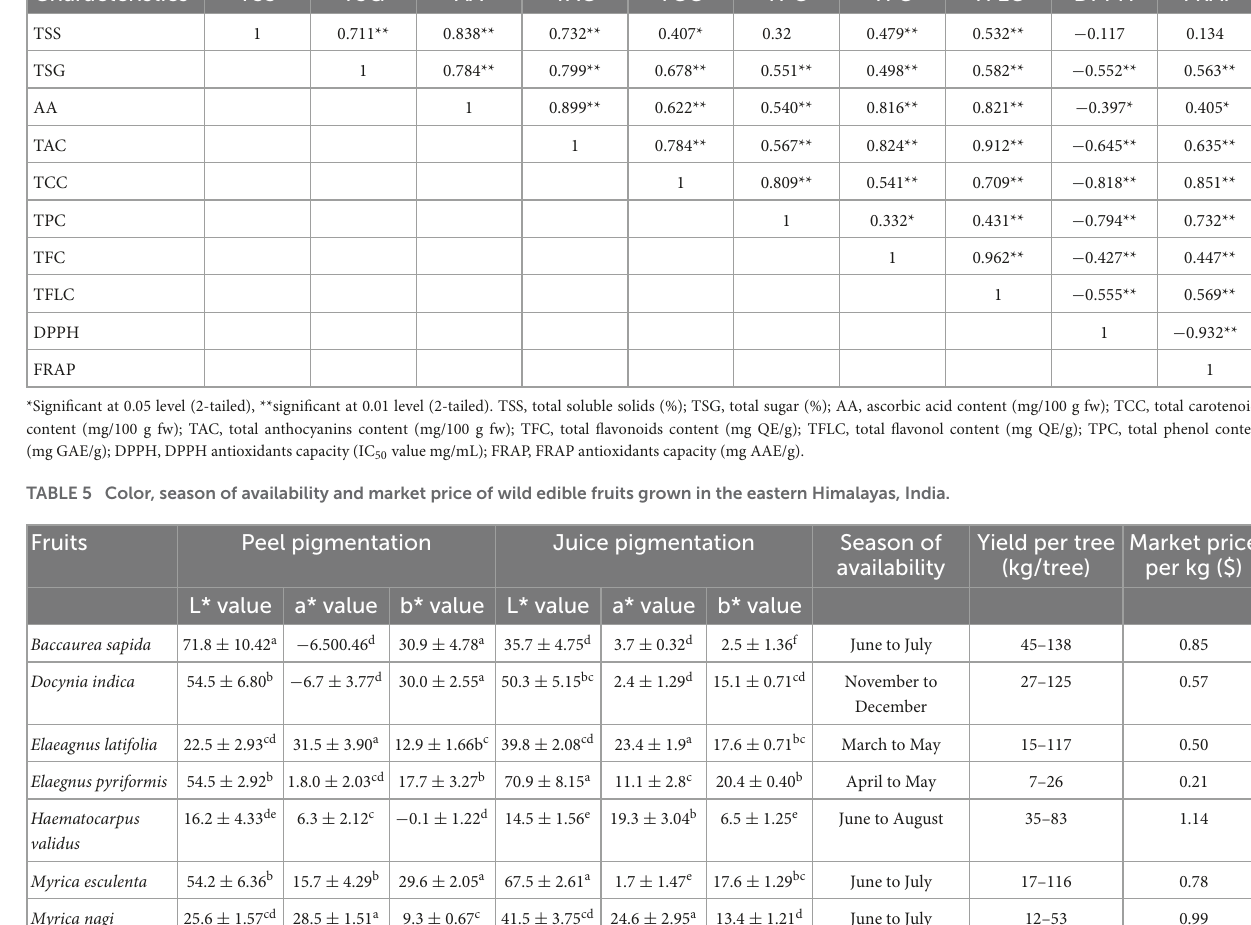
TABLE 4 Pearson’s correlation coefficient (r) among biochemical and antioxidant activities of wild edible fruits grown in the eastern Himalayas, India. Characteristics TSS TSG AA TAC TCC TPC